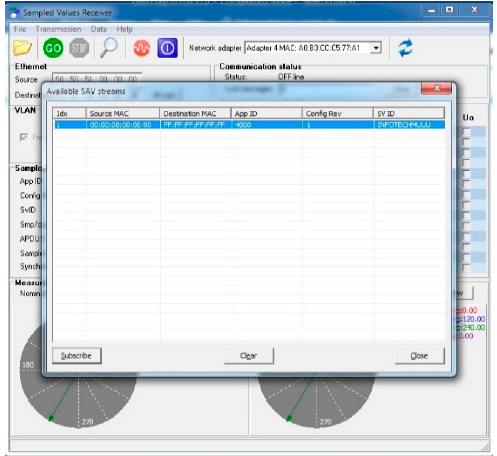
Figure 11. GoSV software program sending custom SV frames.